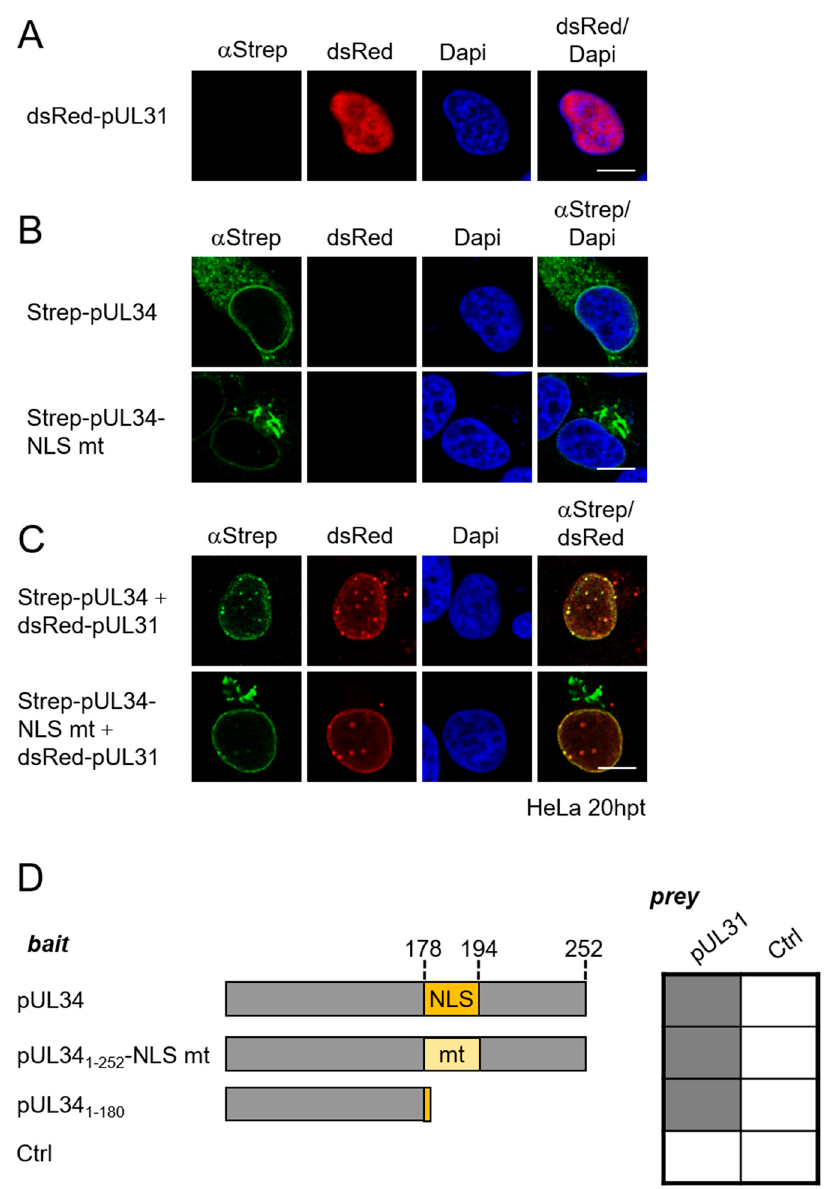
Figure 3. Targeting of pUL34 to the nuclear rim combines active transport and retention by its NEC partner pUL31. To determine the importance of the pUL34-NLS for subcellular localization of pUL34 and NEC formation, ( A ) dsRed-pUL31 and ( B ) Strep-UL34 or Strep-pUL34-NLS mt were expressed in HeLa cells for 20 h either ( A , B ) alone or ( C ) in combinations. Indirect immunofluorescence was performed using anti-Strep tag II antibodies followed by Alexa Fluor 488-conjugated secondary reagents. dsRed-pUL31 was visualized directly and nuclei were detected by Dapi. Scale bars correspond to 10 µm. ( D ) To determine whether mutagenesis of the pUL34-NLS plays a role in interaction of pUL34 with pUL31, the bait plasmids pUL34 1-252 , pUL34 1-252 -NLS mt and pUL34 1-180 (schematically depicted on the left) were co-expressed with the pUL31 prey plasmid. Negative controls (Ctrl) were represented by the respective empty plasmids. Interaction was analyzed by Y2H using the HIS3 reporter gene activation. Grey squares display positive results and white squares display negative results.